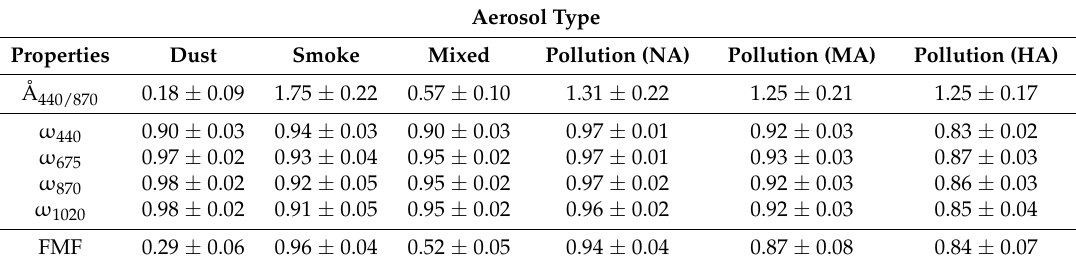
Table 2. Mean value of Ånström exponent at 440–870 nm pair (Å 440-870 ), single scattering albedo ( ω ) and fine-mode fraction (FMF) from the AERONET Version 3 Level 2 inversion product at each representative aerosol source